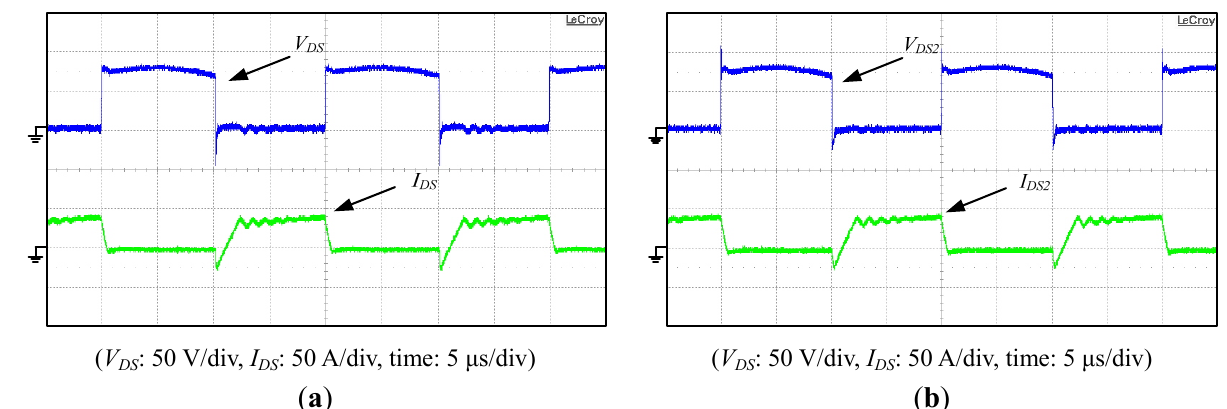
Figure 26. Measured voltage V ( b ) switch M of the proposed converter under full load. 2 B